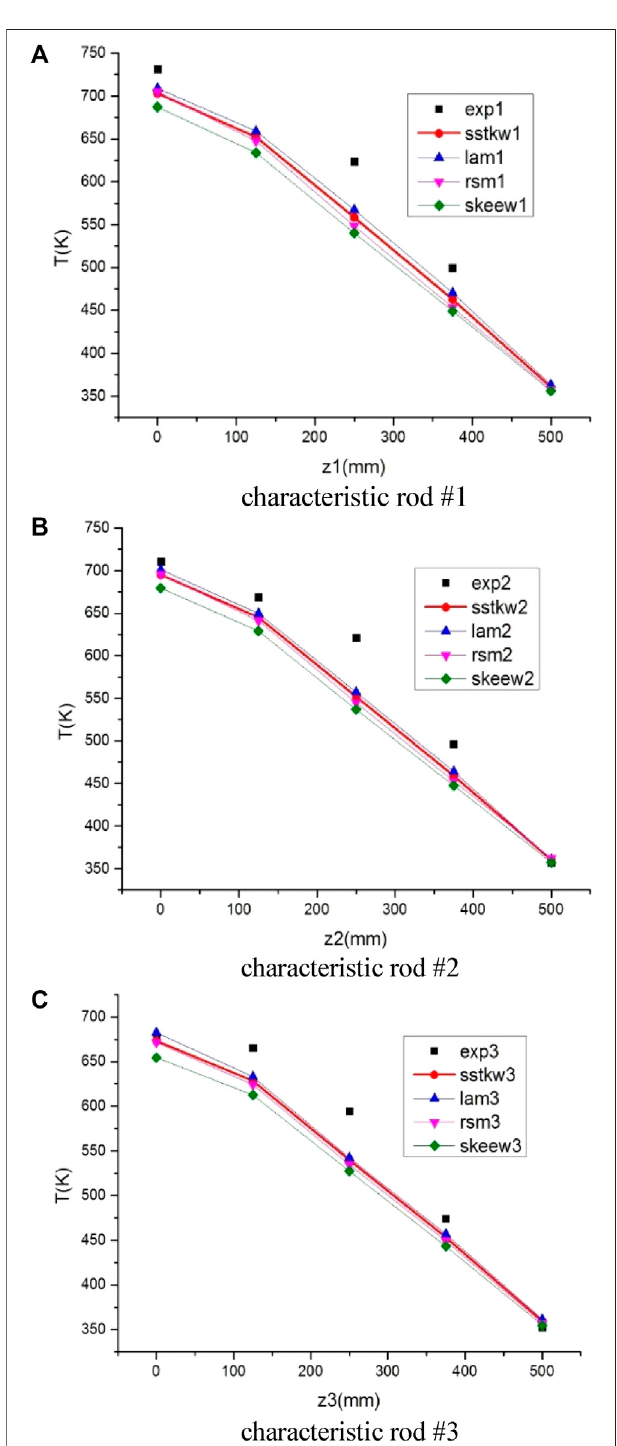
FIGURE 10 | (Continued). Temperature distribution of the six characteristics rods along the axial height in the z-direction. (A)